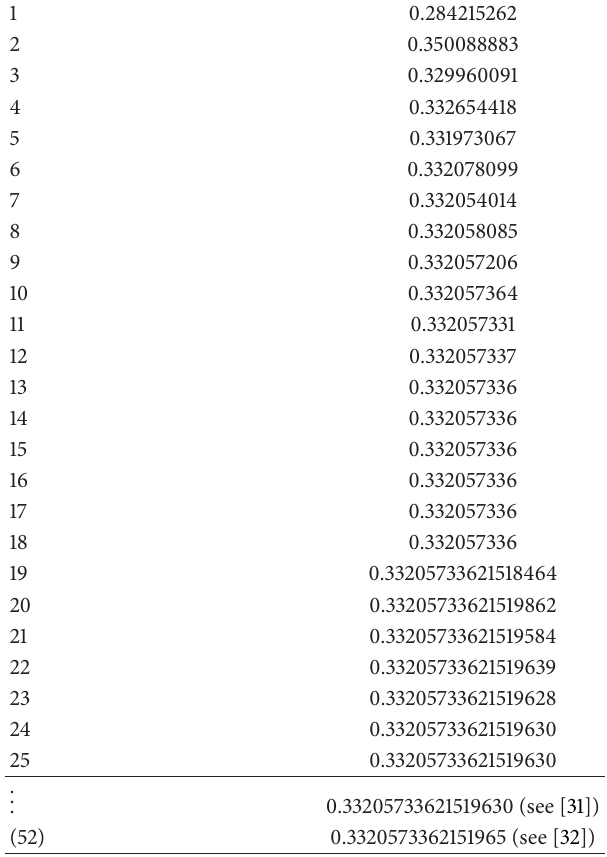
Table 2: Comparison between the SOR improved SLLM ( 𝜔 = 1.2 )